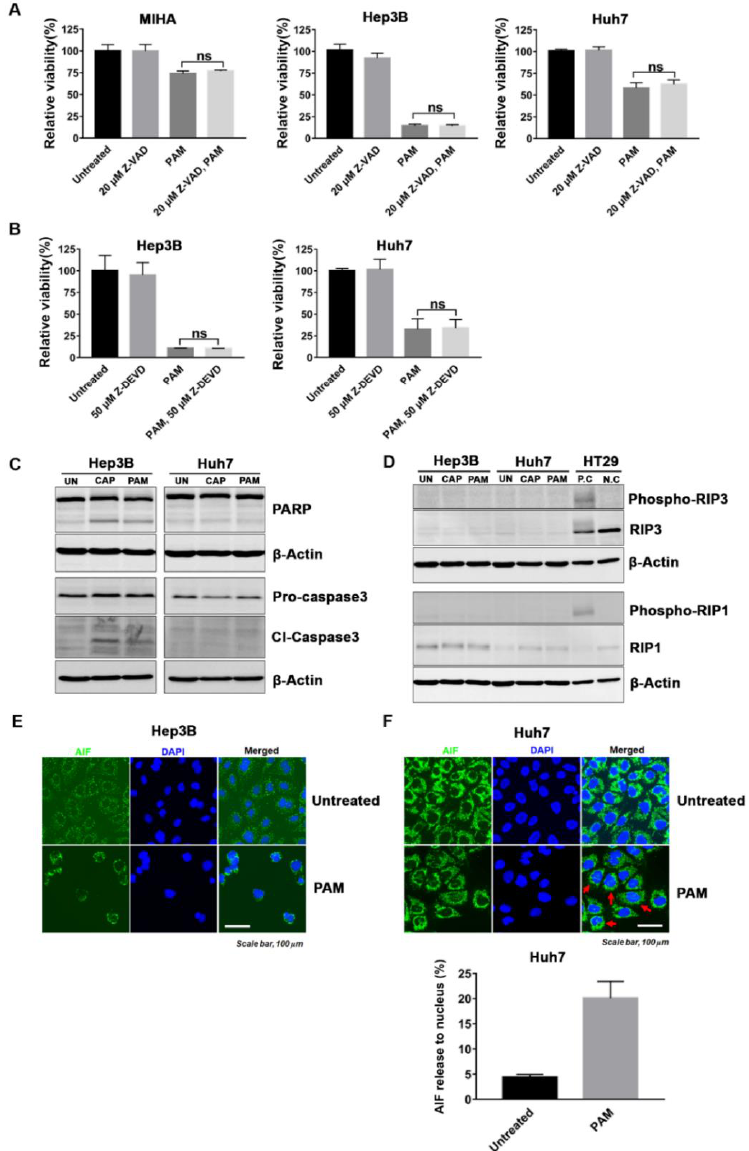
Figure 4. PAM induced caspase-dependent and -independent cell death in HCC. ( A ) MIHA, Hep3B, and Huh7 cells were pre-treated with the pan-caspase inhibitor 20 μM Z-VAD for 1 h followed by PAM treatment. ( B ) Hep3B and Huh7 cells were treated with the caspase-3 inhibitor 50 μM Z-DEVD and PAM. ( A , B ) These cells were incubated further for 72 h, and cell viability was measured by an MTT assay. Data are shown as mean ± SD of at least three independent experiments. ns indicates not significant ( p > 0.05). ( C – F ) After PAM treatment (PAM), Hep3B and Huh7 cells were incubated for a further